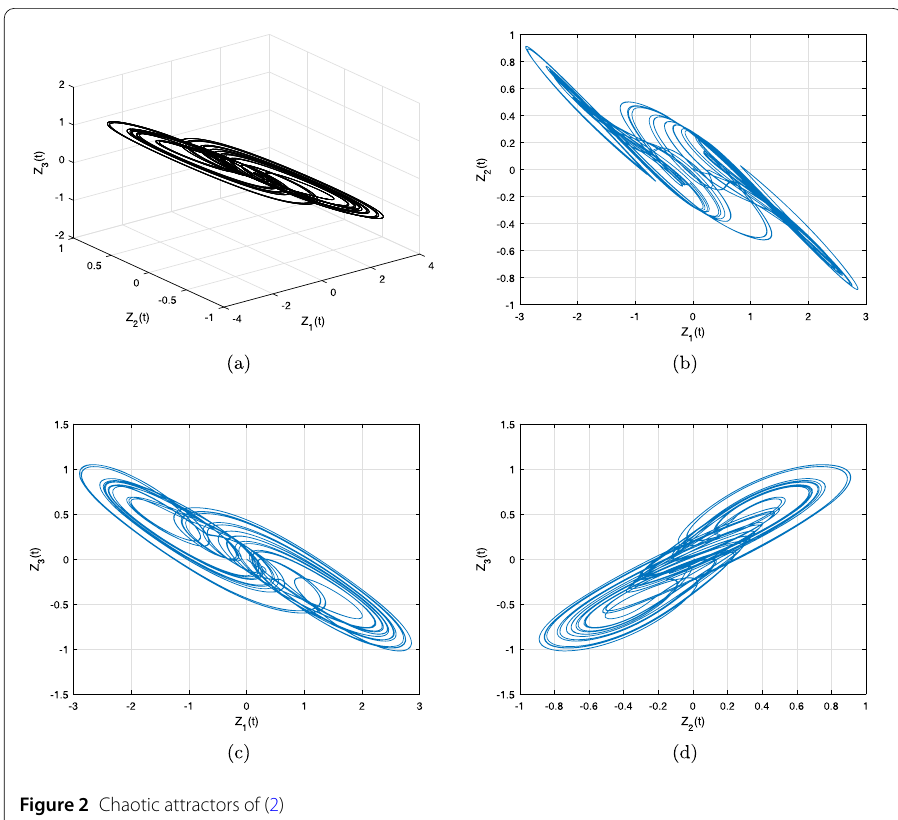
Figure 2 Chaotic attractors of